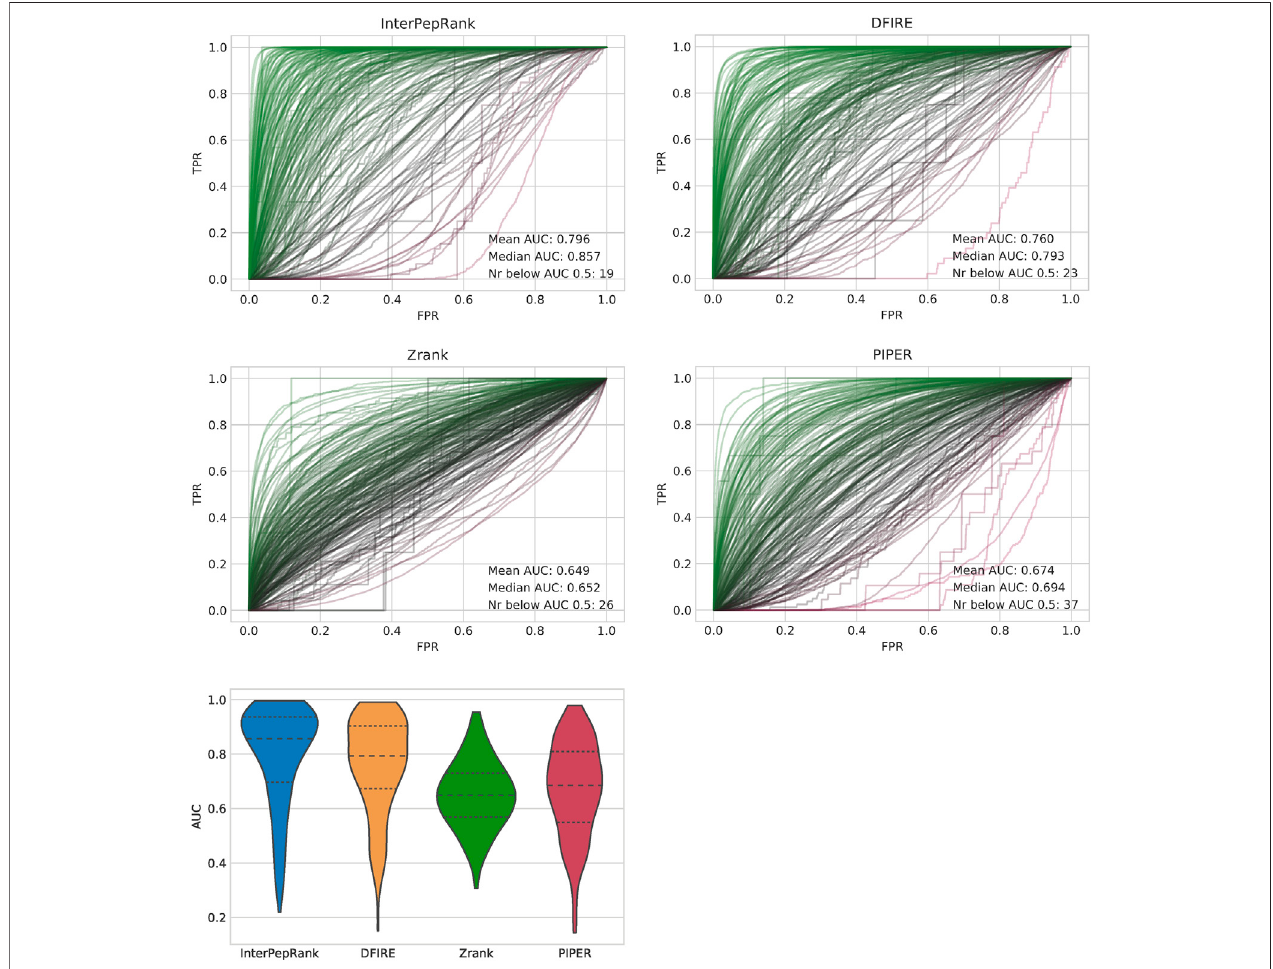
FIGURE 3 | ROC-curves for the different methods, each target is represented by one curve, and a violin-plot over the distributions of AUCs. The area under the curve(AUC)displayedinthegraphsistheaverageandmedianoveralltargets.NotethatwhilethestandarddeviationofAUCishigherforInterPepRank,itstillonlyhas19 targets with an AUC below 0.5, compared to 35, 37, and 26 targets for DFIRE, PIPER, and Zrank,